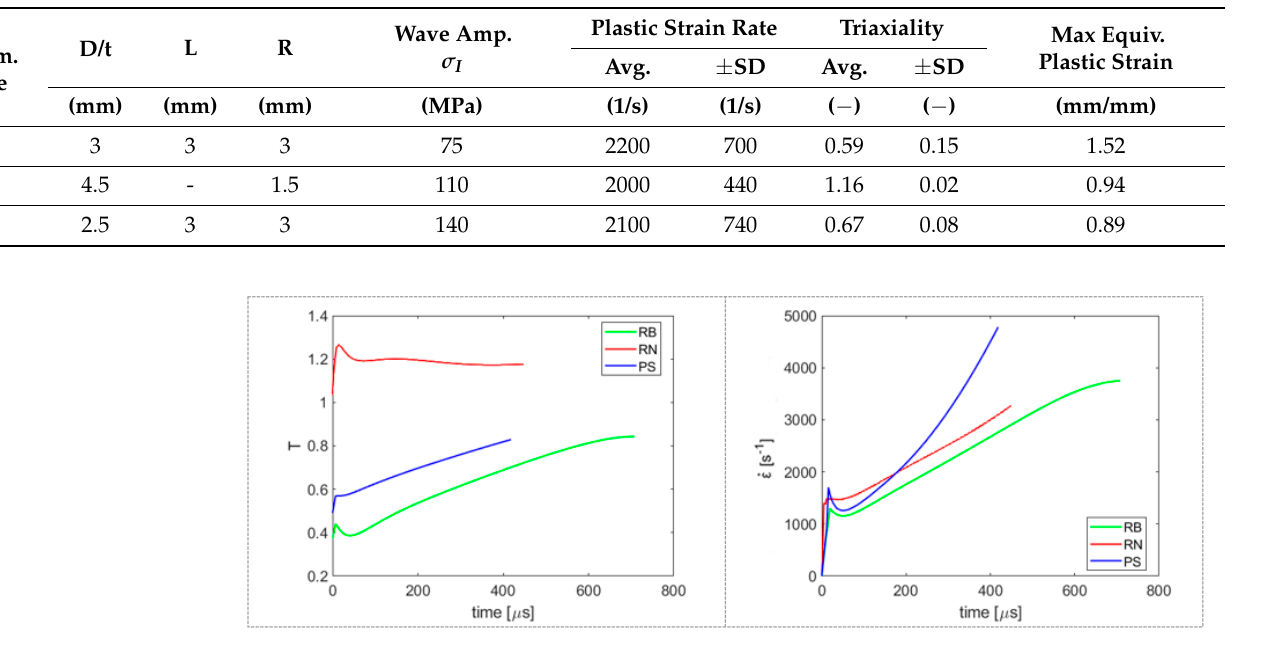
( c ) Figure 5. Specimen geometries: ( a ) round bar; ( b ) round notched bar; ( c ) plane strain. All tests are executed using a Material Testing System (MTS) Criterion 45.105 univer- sal machine, equipped with a two-zone MTS 684 furnace capable of raising sample tem- peratures up to 1000 °C. The test chamber of the furnace has a volume of 50 × 50 × 50 mm 2 . The furnace is controlled by an MTS 409.83, while specimen temperature is measured by two high-temperature thermocouples, fixed to the specimen itself. Axial gauge section elongation is measured by a high-temperature MTS extensometer with ceramic legs and a base length of 25 mm, which can be put in contact with the specimen through a dedicated fence placed in the furnace. Figure 6 illustrates some details of the experimental facility. The MTS TW Elite test software is used for test execution and data acquisition. The tests are conducted with control of displacement, and with constant speeds of 1 mm/s (RB), 0.25 mm/s (RN2) and 0.5 mm/s (PS), which are conditions that could be regarded as quasi-static. During runs, data from the load cell, displacement transducer, extensometer and thermocouples are acquired. Two temperatures are tested, based on results from the literature: 700 °C, which falls in the middle of the typical warm temperature range (600– 800 °C) for steels, and 600 °C, which is regarded by some authors [44] as the best choice